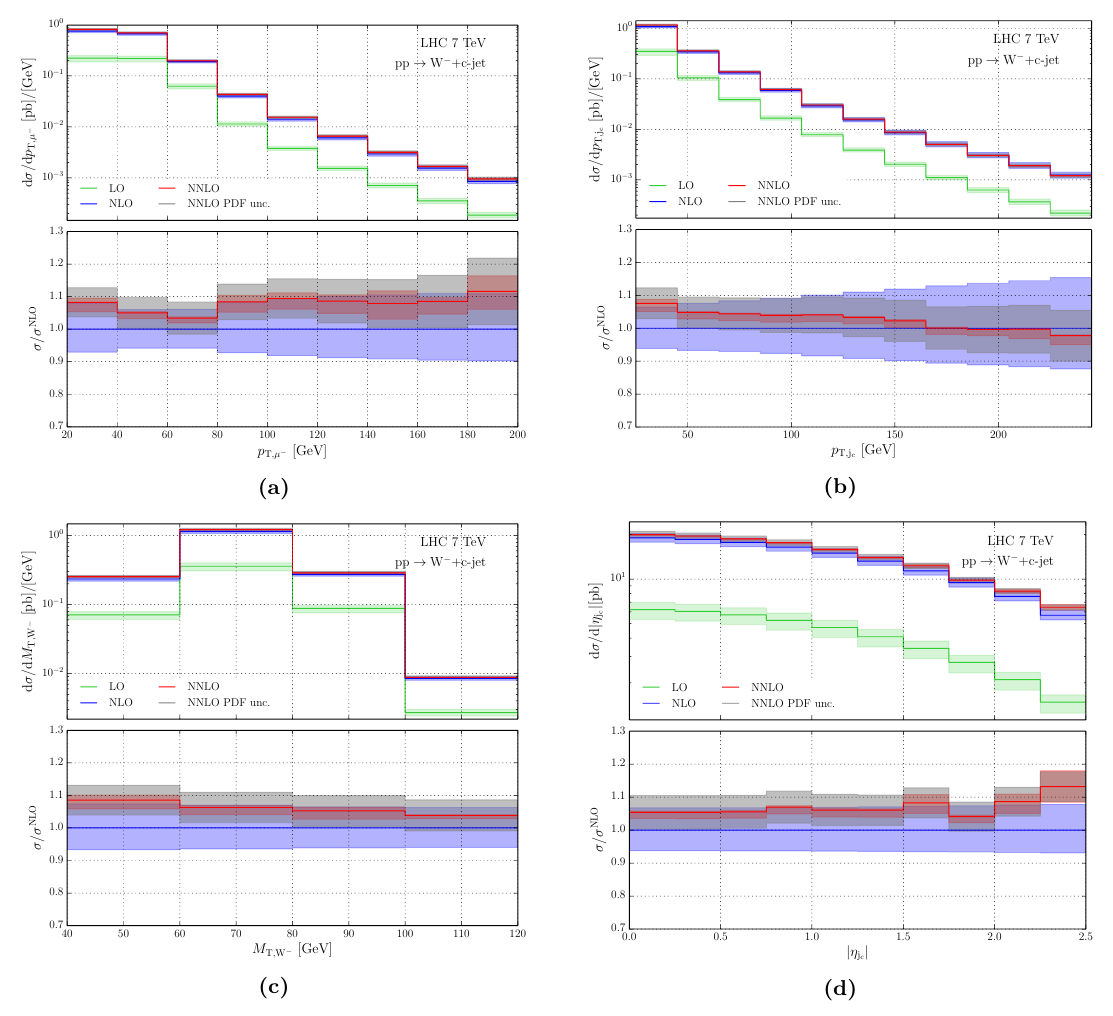
at the 7 TeV LHC: transverse momen- Figure 3. Several differential distributions for pp → W − j c tum of the muon (top left), transverse momentum of the c-jet (top right), transverse mass of the W boson (bottom left), and pseudo-rapidity of the c-jet (bottom right). The upper panels show the absolute distributions in LO, NLO, and NNLO QCD. The lower panels display the same the- oretical predictions but normalised to the central NLO prediction. The grey band represents the PDF variation at NNLO. The green/blue/red bands represent scale uncertainties. The theoretical predictions are obtained for V = 0 cd